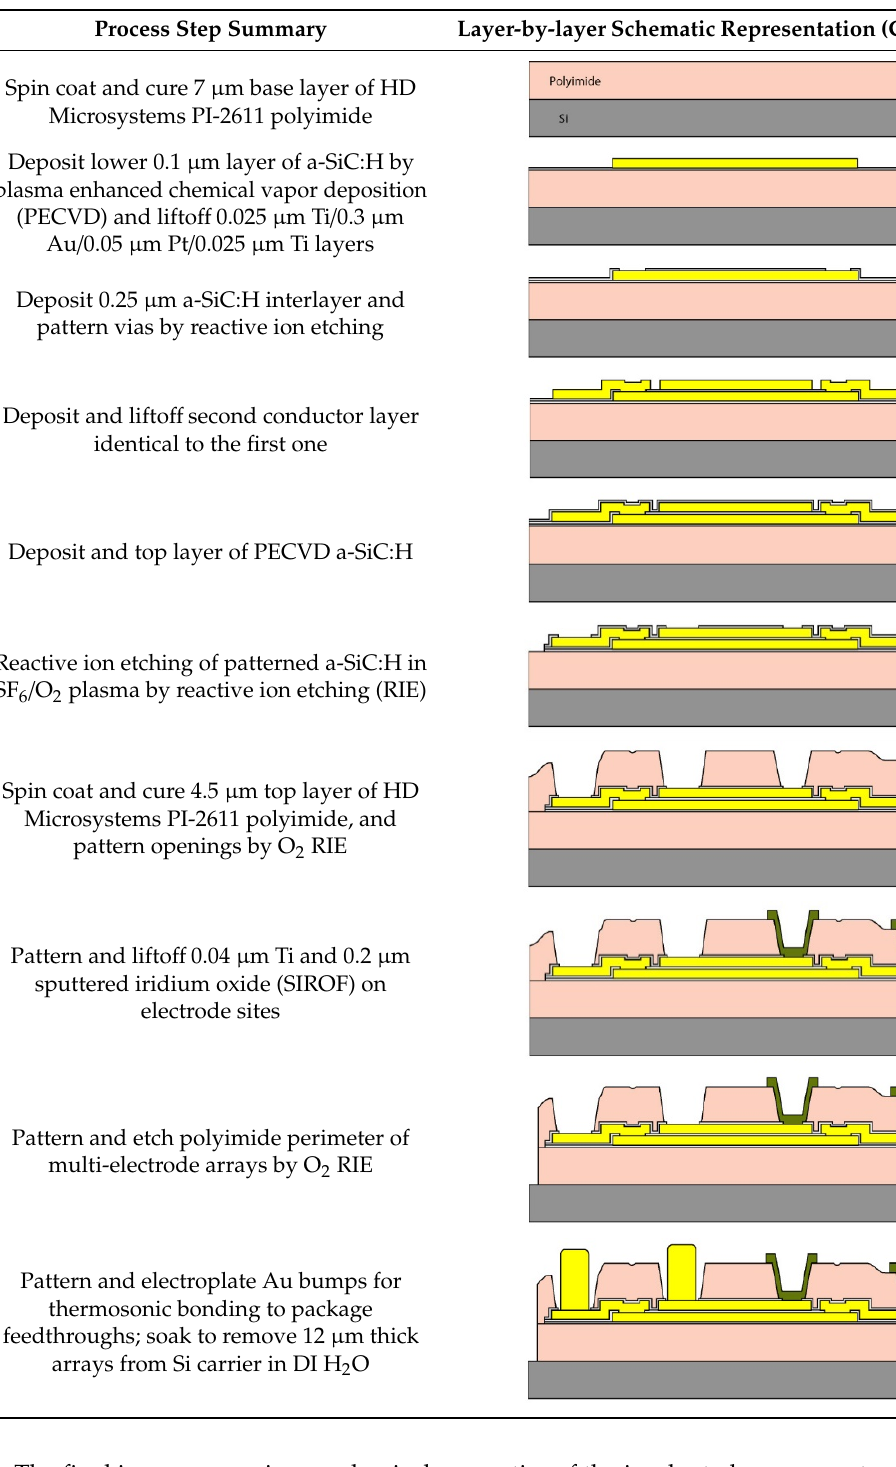
eye including its length (which correlates with the natural refractive state of the eye) and the insertion sites of the extra-ocular muscles, which differ between porcine and human subjects. Table 3. Schematic microfabrication process flow summary for a flexible multielectrode array with Table 3. Schematic microfabrication process flow summary for a flexible multielectrode array with Table 3. Schematic microfabrication process flow summary for a flexible multielectrode array with Table 3. Schematic microfabrication process flow summary for a flexible multielectrode array with Table 3. Schematic microfabrication process flow summary for a flexible multielectrode array with Table 3. Schematic microfabrication process flow summary for a flexible multielectrode array with Table 3. Schematic microfabrication process flow summary for a flexible multielectrode array with Table 3. Schematic microfabrication process flow summary for a flexible multielectrode array with Iridium oxide stimulating sites and two layers of metallization for signal routing. Features are not Table 3. Schematic microfabrication process flow summary for a flexible multielectrode array with Iridium oxide stimulating sites and two layers of metallization for signal routing. Features are not Iridium oxide stimulating sites and two layers of metallization for signal routing. Features are not Iridium oxide stimulating sites and two layers of metallization for signal routing. Features are not Table 3. Schematic microfabrication process flow summary for a flexible multielectrode array with Iridium oxide stimulating sites and two layers of metallization for signal routing. Features are not Iridium oxide stimulating sites and two layers of metallization for signal routing. Features are not Table 3. Schematic microfabrication process flow summary for a flexible multielectrode array with Iridium oxide stimulating sites and two layers of metallization for signal routing. Features are not Iridium oxide stimulating sites and two layers of metallization for signal routing. Features are not drawn to scale, for visibility. Iridium oxide stimulating sites and two layers of metallization for signal routing. Features are not drawn to scale, for visibility. drawn to scale, for visibility. drawn to scale, for visibility. Iridium oxide stimulating sites and two layers of metallization for signal routing. Features are not drawn to scale, for visibility. drawn to scale, for visibility. Iridium oxide stimulating sites and two layers of metallization for signal routing. Features are not drawn to scale, for visibility. drawn to scale, for visibility. drawn to scale, for visibility. drawn to scale, for drawn to scale, for visibility.